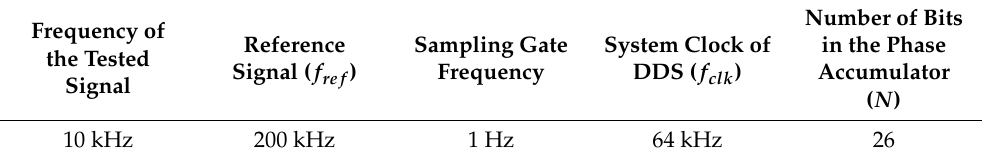
Table 1. Simulation parameters of the key components in the